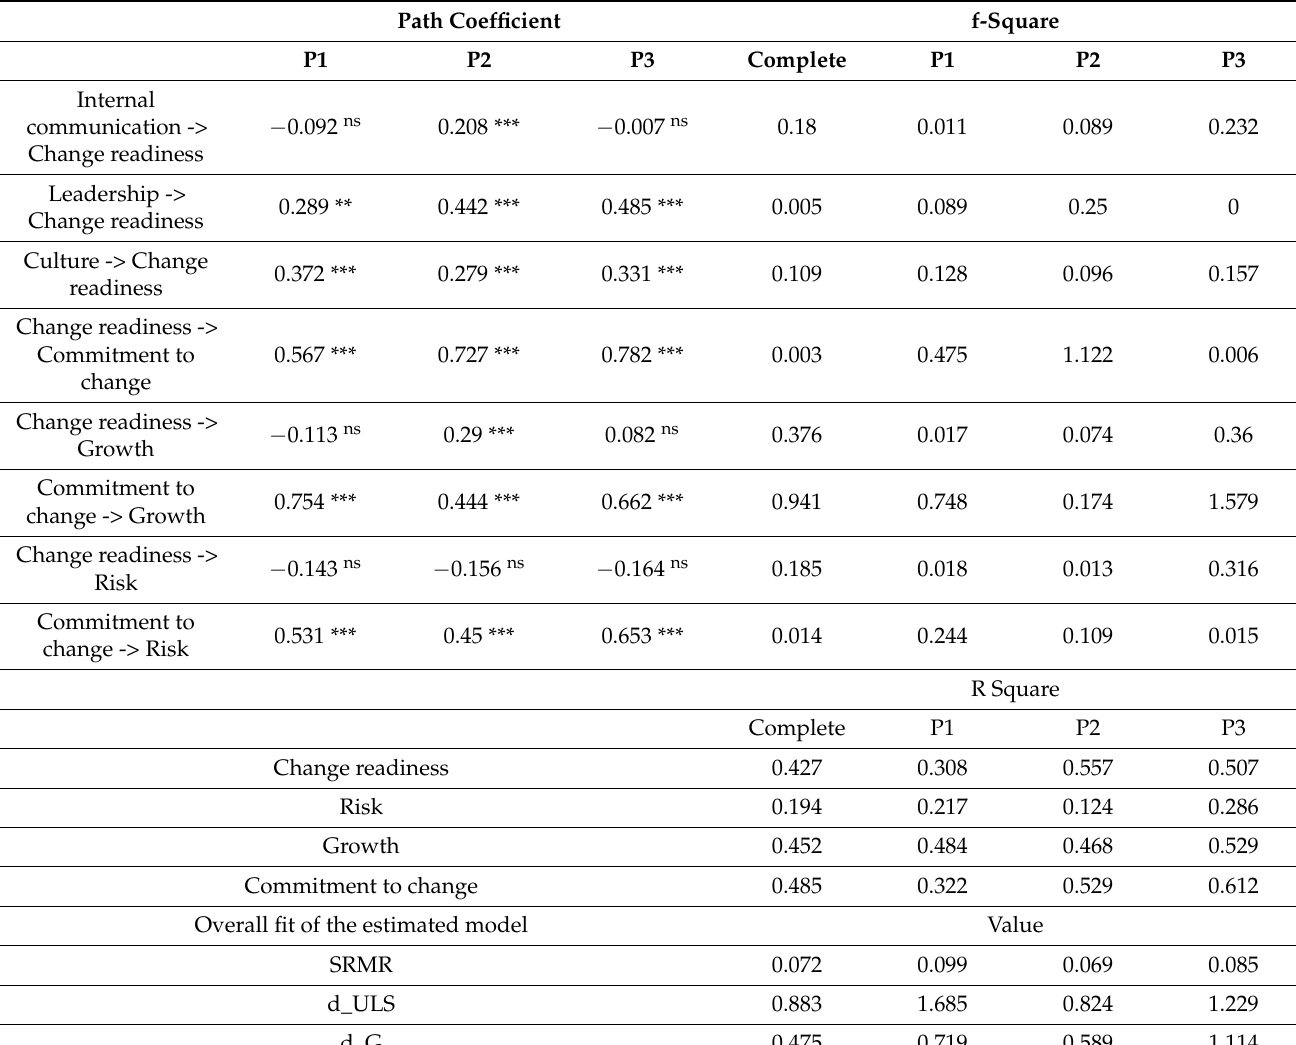
Table 5. Structural model